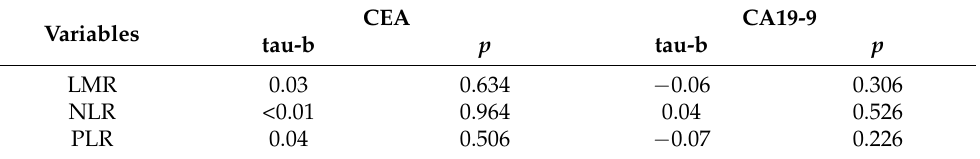
Table 6. Correlation analysis between CEA, CA19-9 and LMR, NLR, PLR. CEA CA19-9 Variables tau-b p tau-b p LMR 0.03 0.634 − 0.06 0.306 NLR <0.01 0.964 0.526 PLR 0.04 0.506 − 0.07 0.226 LMR, lymphocyte-to-monocyte ratio; NLR, neutrophil-to-monocyte ratio; PLR, platelet-to-lymphocyte ratio; CEA, carcinoembryonic antigen; CA19-9, carbohydrate antigen 19-9; tau-b, Kendall’s correlation coefficient; p , p value for correlation